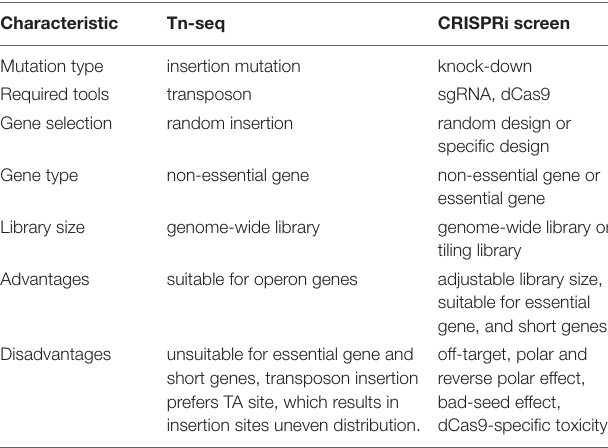
TABLE 3 | Comparison of Tn-seq and CRISPRi screen.